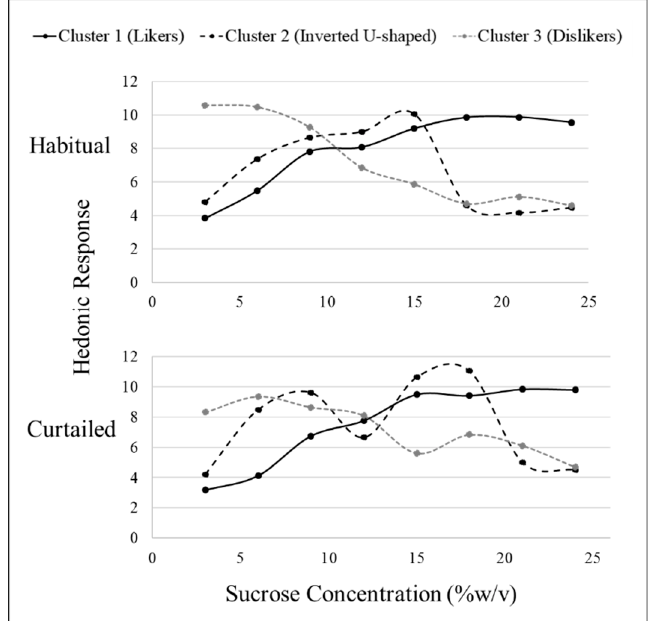
Figure 1. Hierarchical cluster analysis identified three sucrose sweet liking phenotypes based on sweet liking response using a 15 cm visual analog scale; however, patterns differed between habitual and curtailed nights. After the habitual night, cluster 1 ( n = 25), cluster 2 ( n = 6), and cluster 3 ( n = 9) demonstrated the fundamental phenotypes of sweet liking. After the curtailed night, cluster 1 ( n = 28) and cluster 3 ( n = 8) retained the familiar fundamental patterns of liking; whereas, cluster 2 ( n = 4) had a distorted pattern.